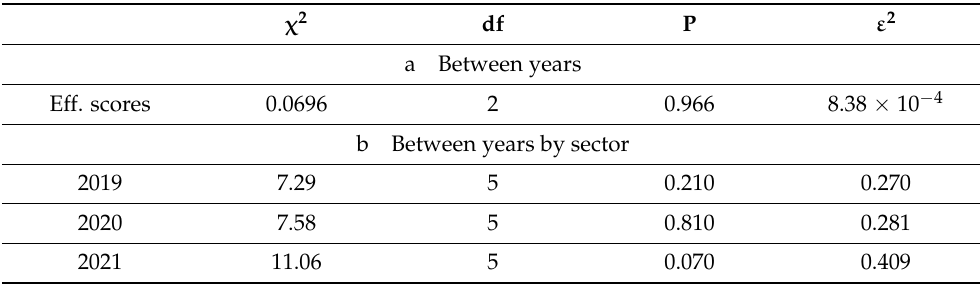
Table 8. Kruskal–Wallis for the acquired efficiency scores: (a) between years, (b) between years by